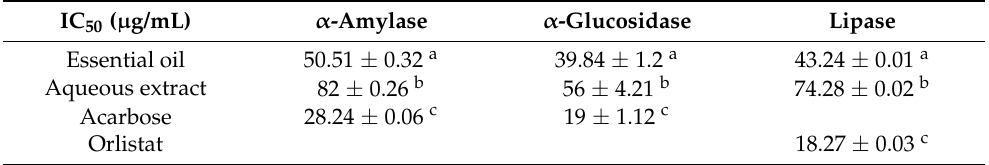
Table 6. Activity of O. basilicum to inhibit digestive enzymes ( α -glucosidase, α -amylase, and lipase). IC 50 ( µ g/mL) α -Amylase α -Glucosidase Lipase Essential oil